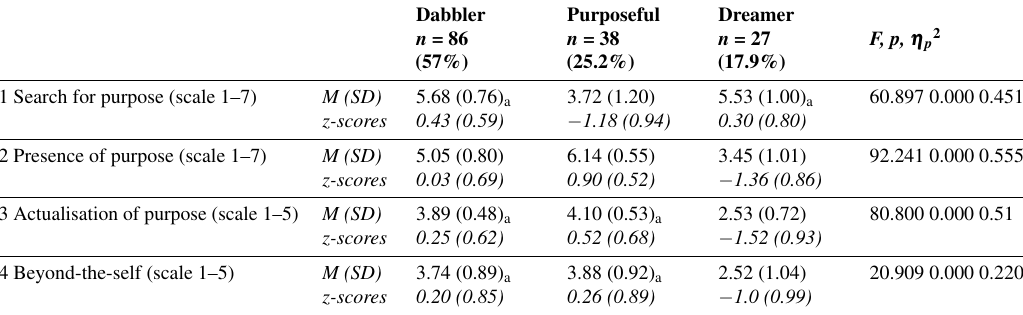
Table 4. Clusters of Finnish social services students’ purpose